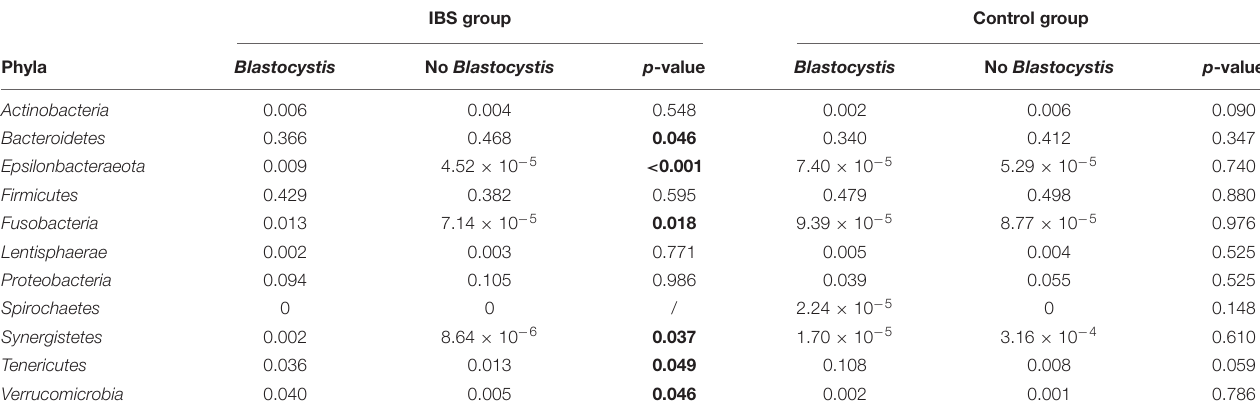
TABLE 1 | Relative abundances of bacterial